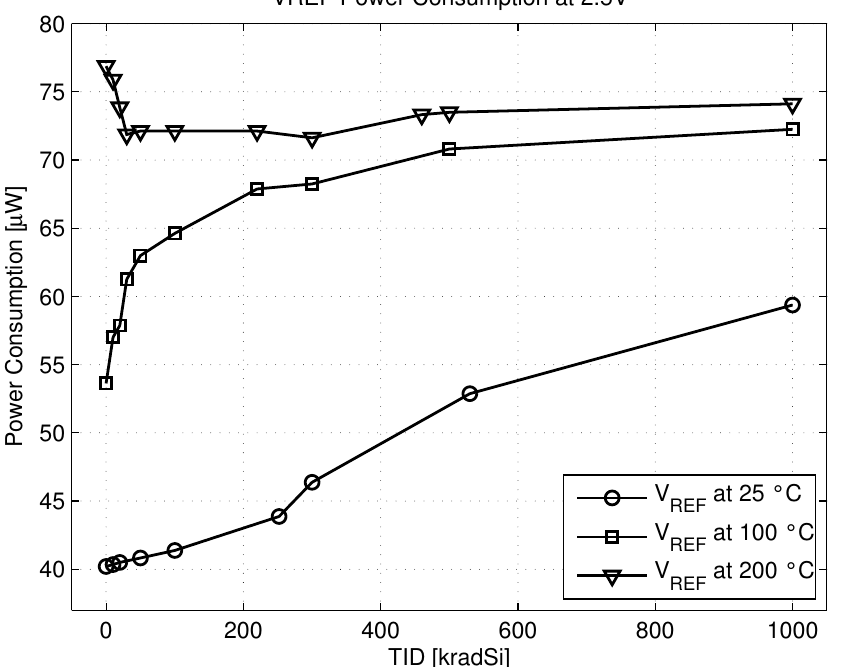
Figure 11. Measured voltage reference power consumption at 2.5 V power supply, in the same conditions as in Figure